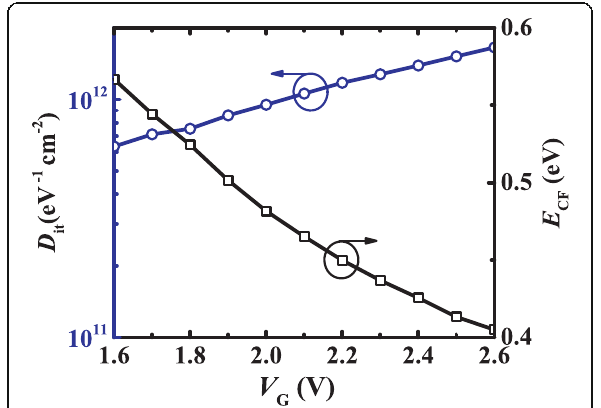
Fig. 5 Plots of D IT and the interface trap energy level relative to the CB ( Δ E IT =E C - E IT ) for each applied gate voltage in the subthreshold